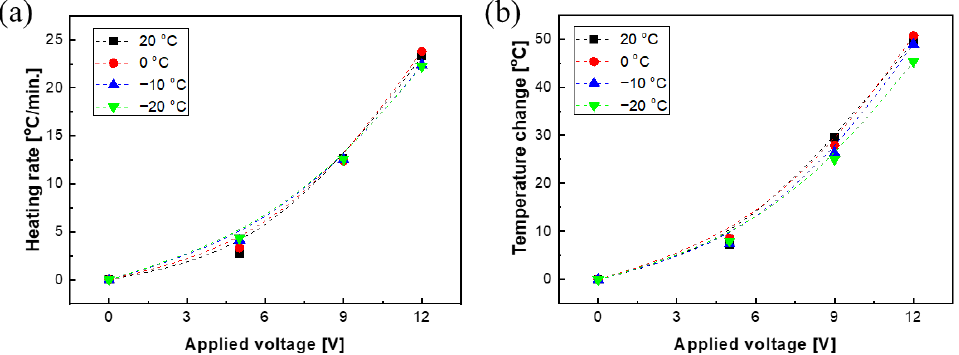
Figure 7. Heating characteristic of MWCNT/PDMS under different environmental temperatures; ( a ) heating rate and ( b ) temperature change.